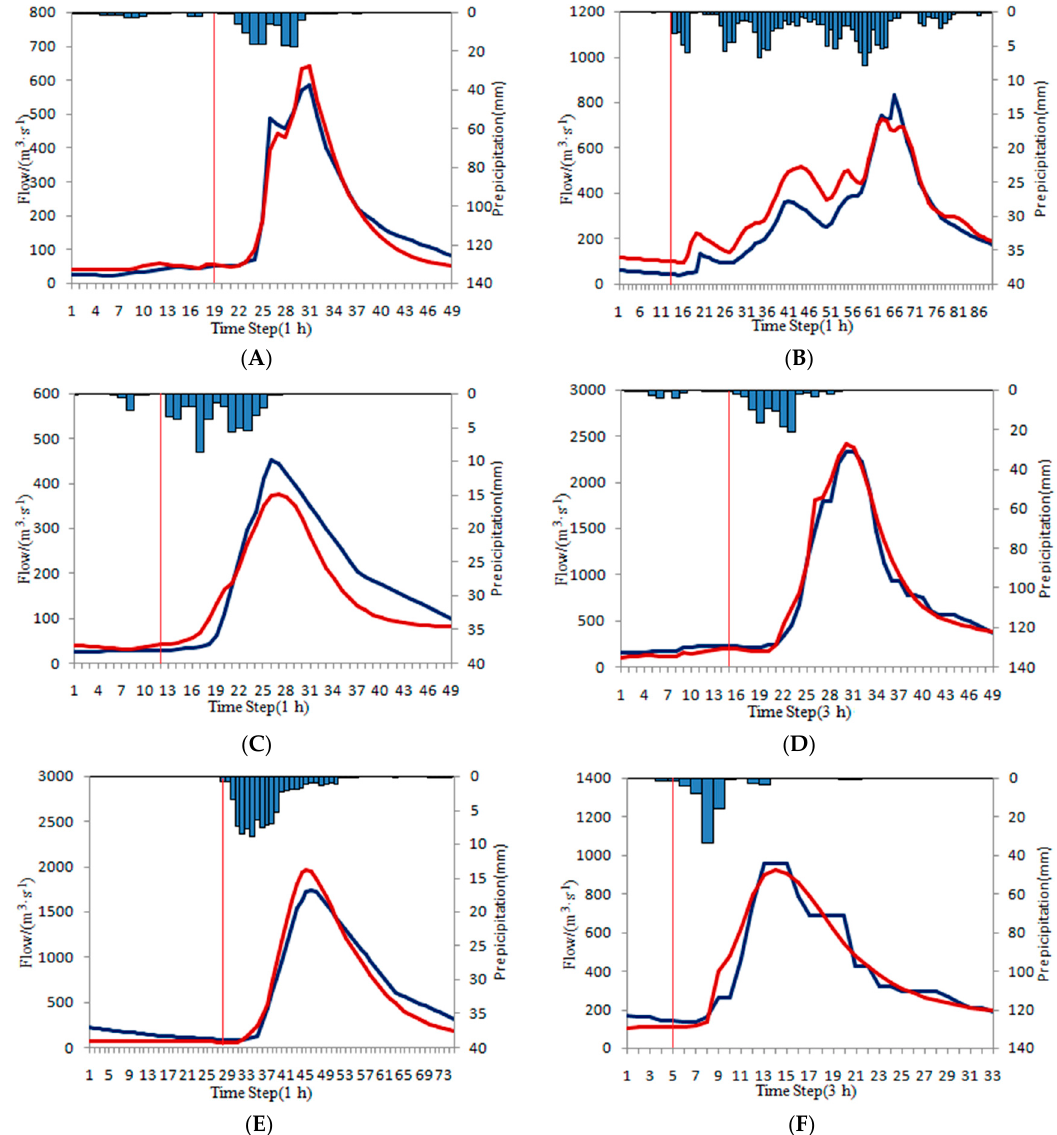
Figure 9. Complex flood. ( A ) Zhongzhou; ( B ) Zhonggeng 17 June 1993 8:00–21 June 1993 0:00; ( C ) Zhonggeng 22 June 1992 8:00–24 June 1992 8:00; ( D ) Shangshalan; ( E ) Jingjukou; ( F ) Saitang.